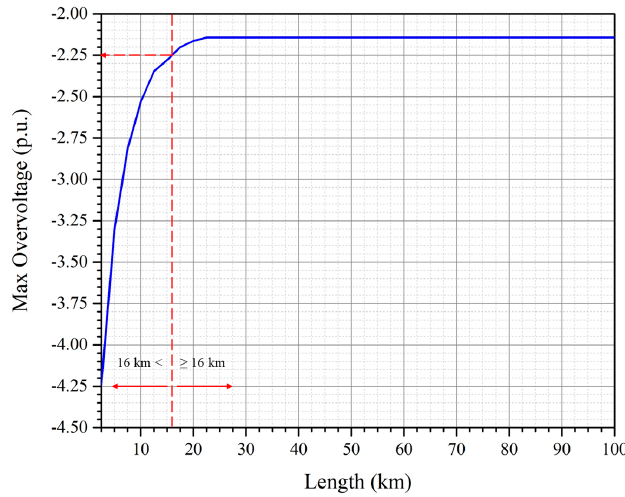
Figure 20. Maximum core-ground overvoltage according to the cable length.